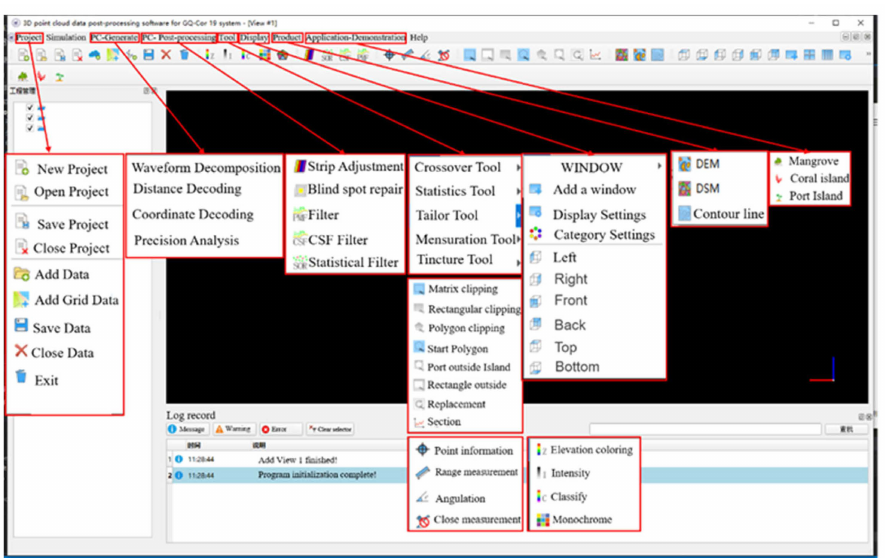
Figure 19. A screen shot for the GQ-Cor 19 data post-processing software with Chinese